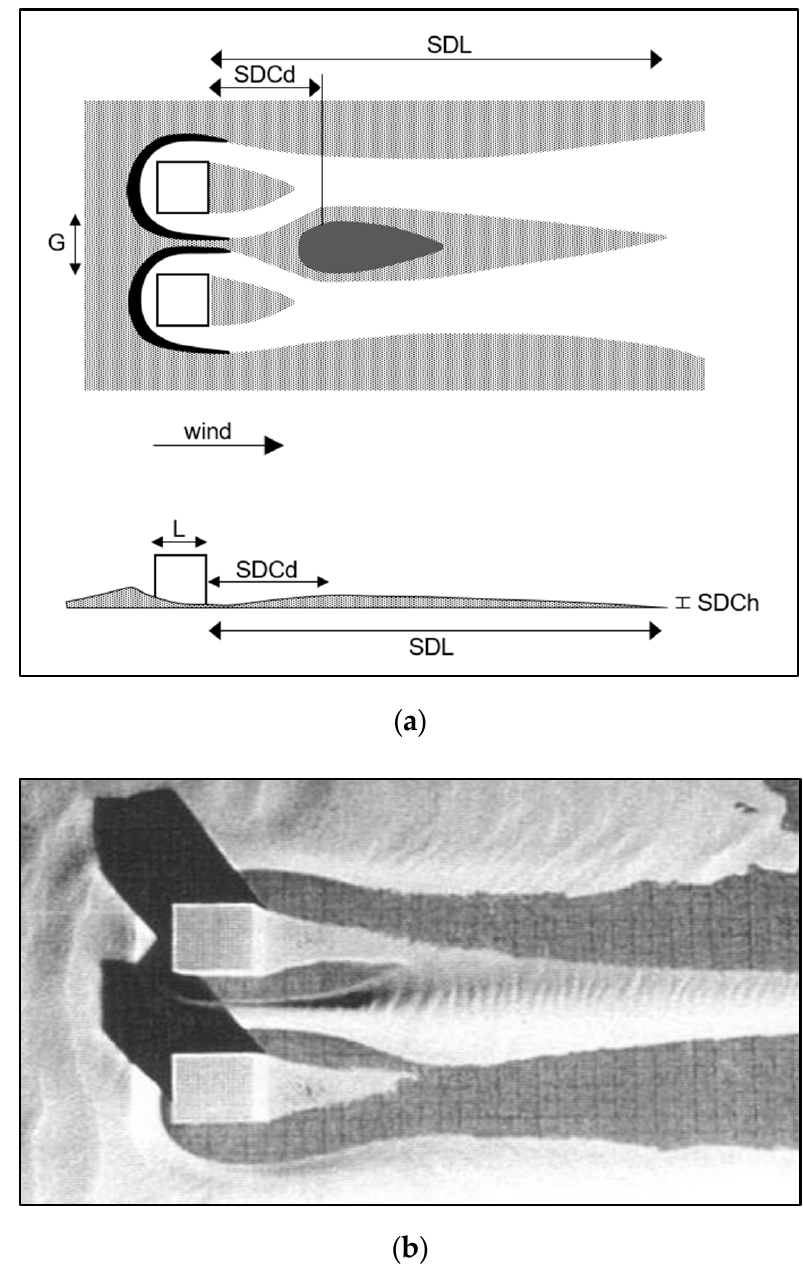
Figure 20. ( a ) Diagram illustrating the sand accumulation parameters for two cubic buildings; ( b ) sand accumulation pattern in the wind tunnel (photo: M. Sherzad).